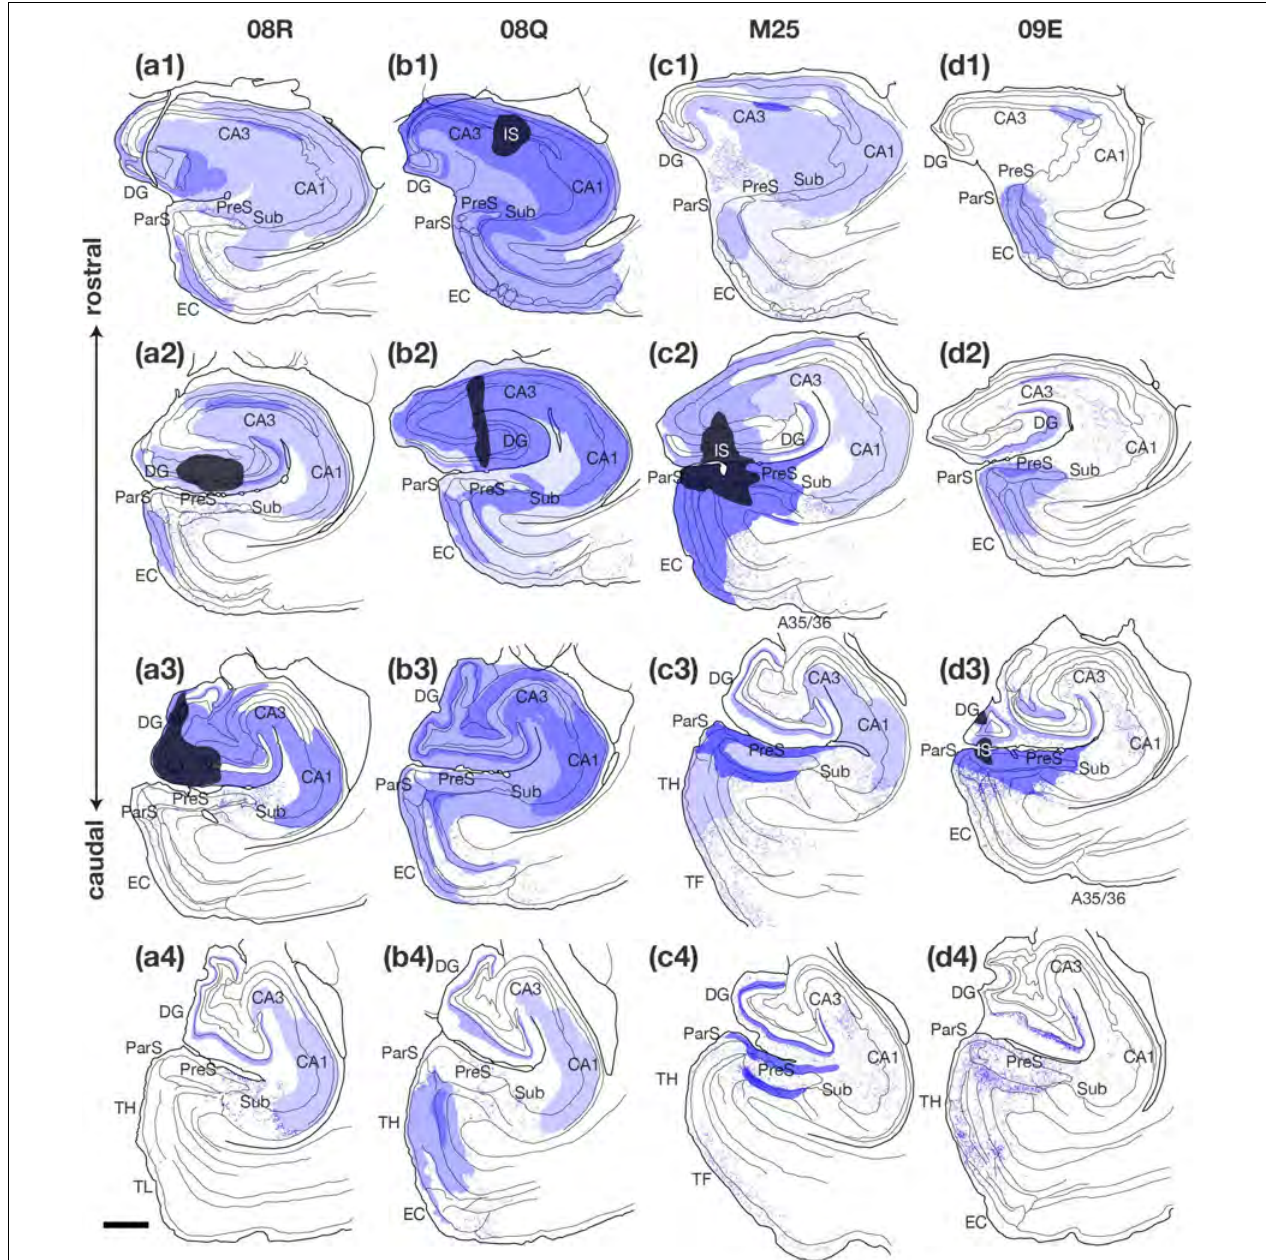
FIGURE 8 | Plotting of anterogradely labeled terminals in the hippocampal and parahippocampal areas on the ipsilateral side of the BDA injection site. Sections in each case are presented from rostral (1) to caudal (4) levels at 1- to 2-mm intervals as indicated in the unfolded maps in Figure 6 . Injection sites and their diffusion are indicated by black and dark blue areas, respectively. Blue dots represent single anterogradely labeled terminal boutons. Regions of dense anterograde label distribution are represented by deep or pale purple color and plotting of the labeled termimal boutons was difficult within these regions. Scale bar = 1 mm. A35/36, areas 35 and 36 (the perirhinal cortex); CA, cornu ammonis; DG, dentate gyrus; EC, entorhinal cortex; IS, injection site; ParS, parasubiculum; PreS, presubiculum; Sub, subiculum; TF, area TF; TH, area TH. Note that, in case 08Q, BDA injection site included CA1 and there was a larger number of labeled fibers and